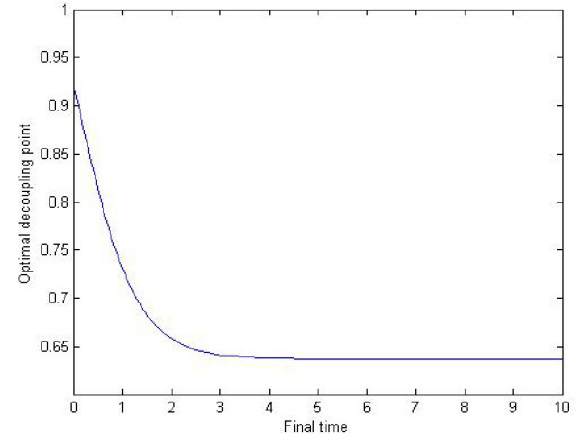
Figure 4. The relationships between the optimal decoupling point and final time where